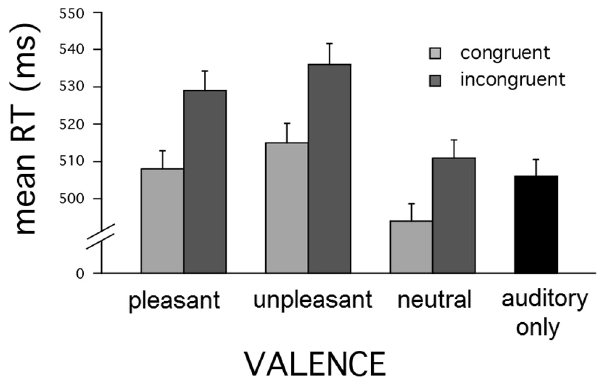
Figure 1. Overview of findings in Experiment 1 (auditory classification). Average response times as a function of emotional valence (pleasant, neutral, unpleasant pictures) in the visual scene and of crossmodal congruence. Error bars: 1